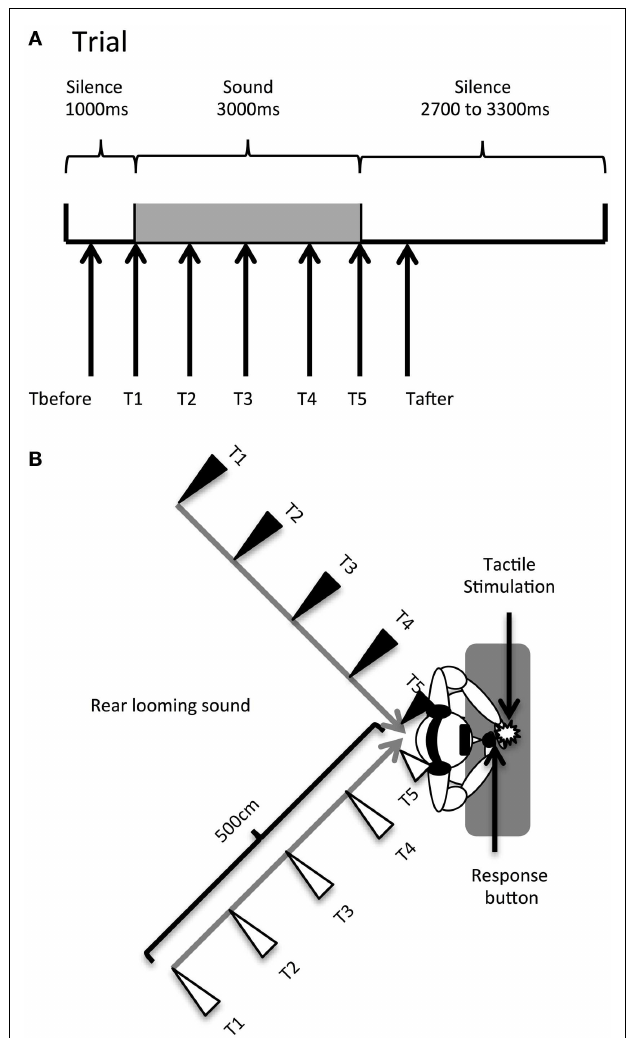
FIGURE 1 |Audiotactile test . (A) . Description of a trial. (B) Experimental setup. Participants received a tactile stimulus at their hand while task-irrelevant sounds (threatening or non-threatening) approached them from the rear hemi-field, either in the left or the right hemi-space.When participants perceived the tactile stimulation, the looming sounds were located at different distances; this was accomplished by delivering the tactile stimulus at different temporal delays starting from sound onset (T before ,T1,T2,T3,T4,T5,T after ).The sound source location at each temporal delay condition is indicated by triangles (black triangles for the left hemi-space and white triangles for the right